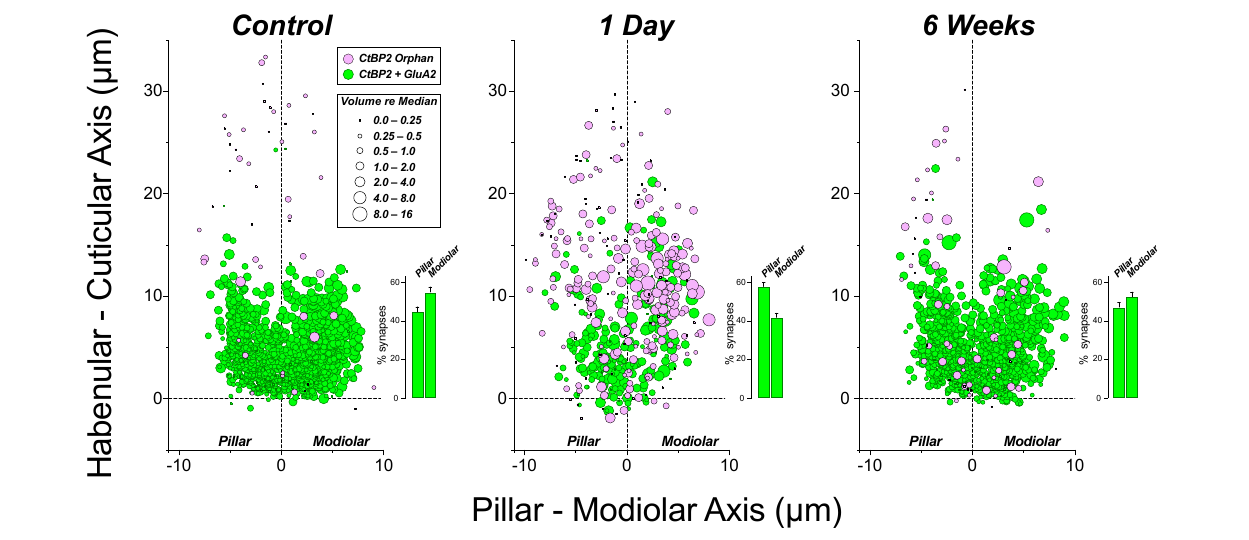
FIGURE 9 | At 1 day post-exposure, many of the ribbons abnormally distant from the IHC habenular pole are unpaired with post-synaptic GluA2 patches, especially on the modiolar side of the IHC. Insets in each panel show the mean percentage of synapses ( ± SEMs) on the pillar vs. modiolar sides of the IHCs across all cases from the relevant group. Data are from 4 ears from 4 animals in control and 1-day groups, and 4 ears from 2 animals in the 6-weeks group. Two ears in the 1 day post exposure group that showed little synaptopathy at 22 kHz were identified as outliers (ROUT method Q = 1%), and were not included in this figure, but were included in all other figures displaying 1-day data.